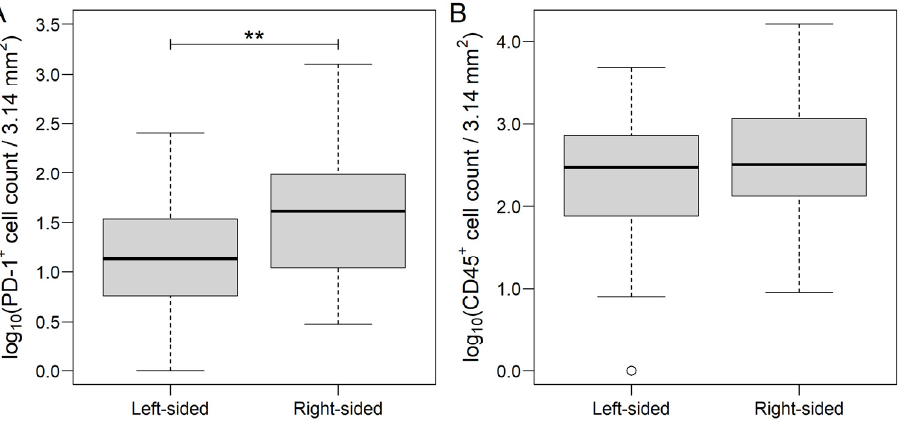
Figure 2. Programmed cell death protein 1 (PD ‐ 1, ( A )) and CD45 ( B ) count data of left ‐ sided and right ‐ sided colorectal cancer samples. While PD1 was significantly different between the two sides, only marginal difference was justified in the case of CD45. The thick line represents the median value. ** p < 0.01.